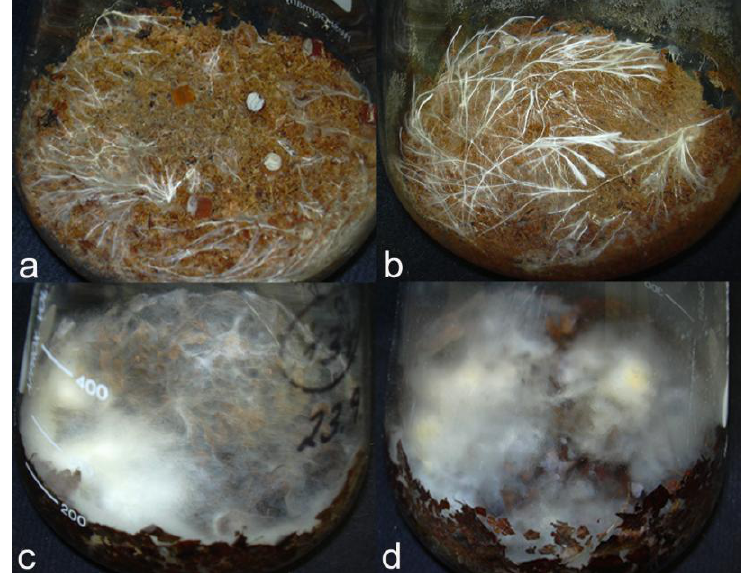
Figure 10. Mycelial growth on different lignocellulosic substrates: C. strossmayeri strain 15-2C on (a) Populus sp. and (b) F. sylvatica sawdust and (c) C. aff. radians strain 1-2PS on Q. robur and (d) A. platanoides leaf litter after (a, b) 3 and (c, d) 1.5 months at 28